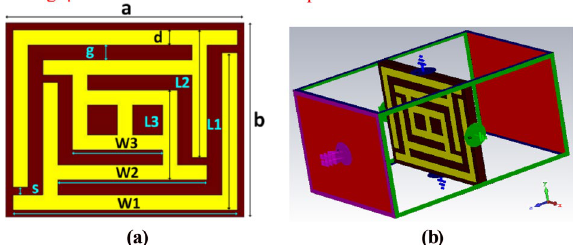
Figure 3. ( a ) The geometry and ( b ) the boundary setup of the metamaterial unit cell.